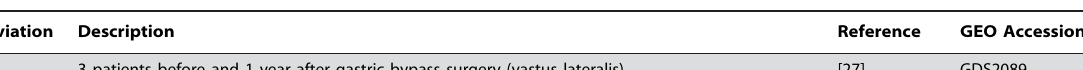
Table 1. Datasets used to create context-specific skeletal muscle